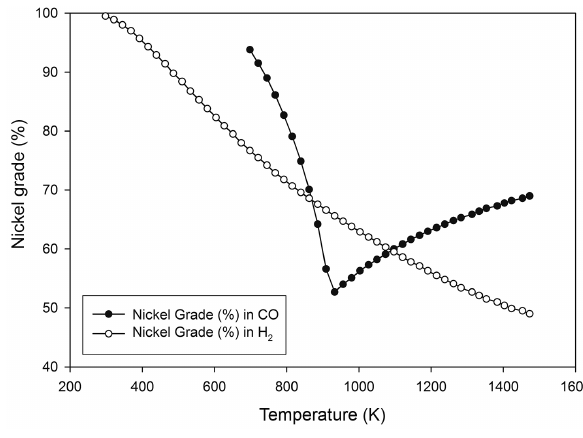
Figure 12: Effect of temperature on the nickel grade of the ferronickel as a function of temperature for reduction of the ore in pure carbon